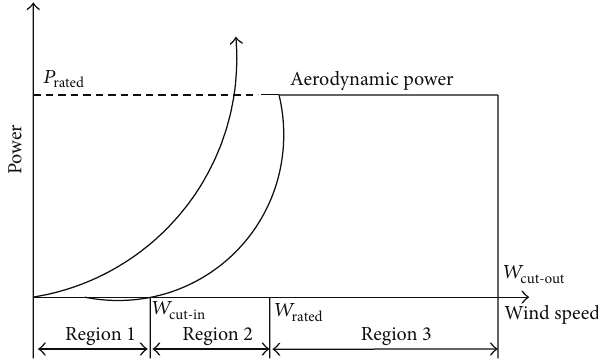
Figure 1: Power operating region of wind turbines.